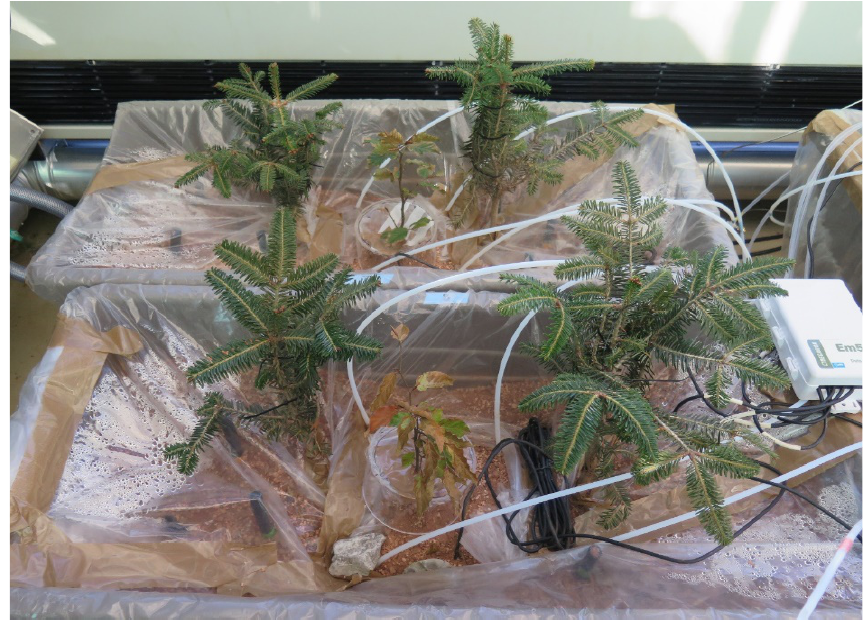
Figure 2. Photo of two mesocosms with silver-fir and European beech saplings in separate compartments.